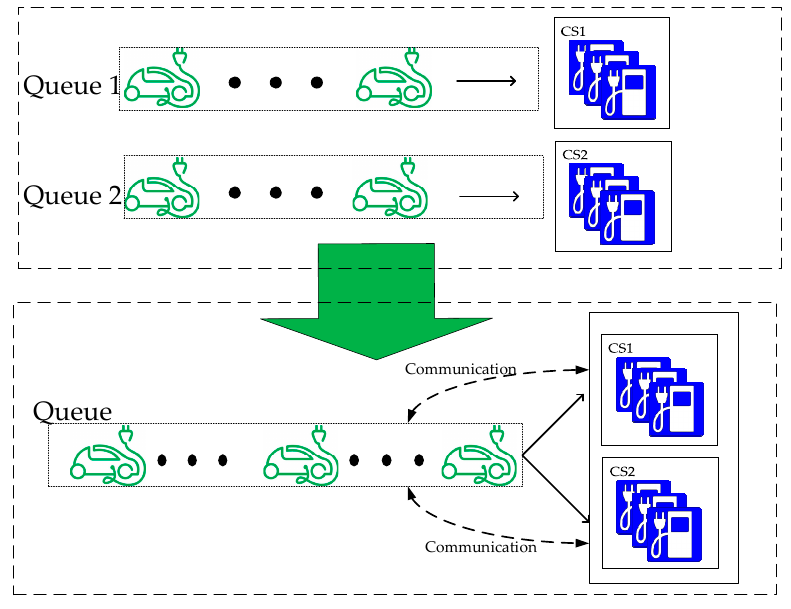
Figure 5. Queuing system optimization.